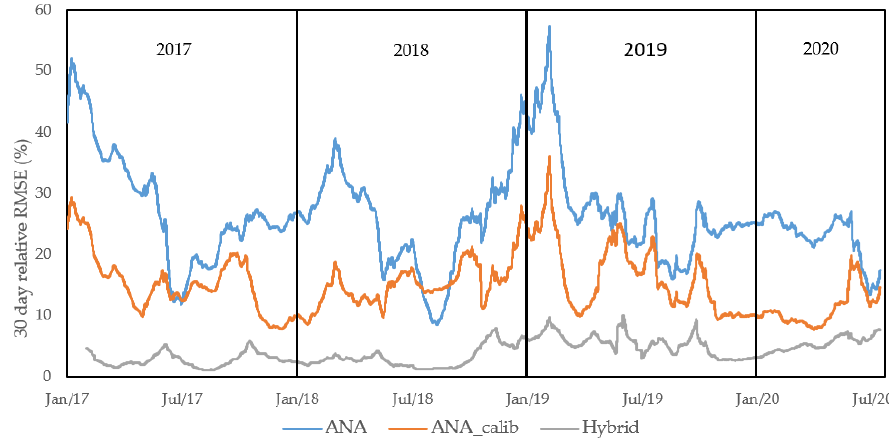
Figure 9. 30-day relative RMSE of the hybrid model compared to two analytical models.